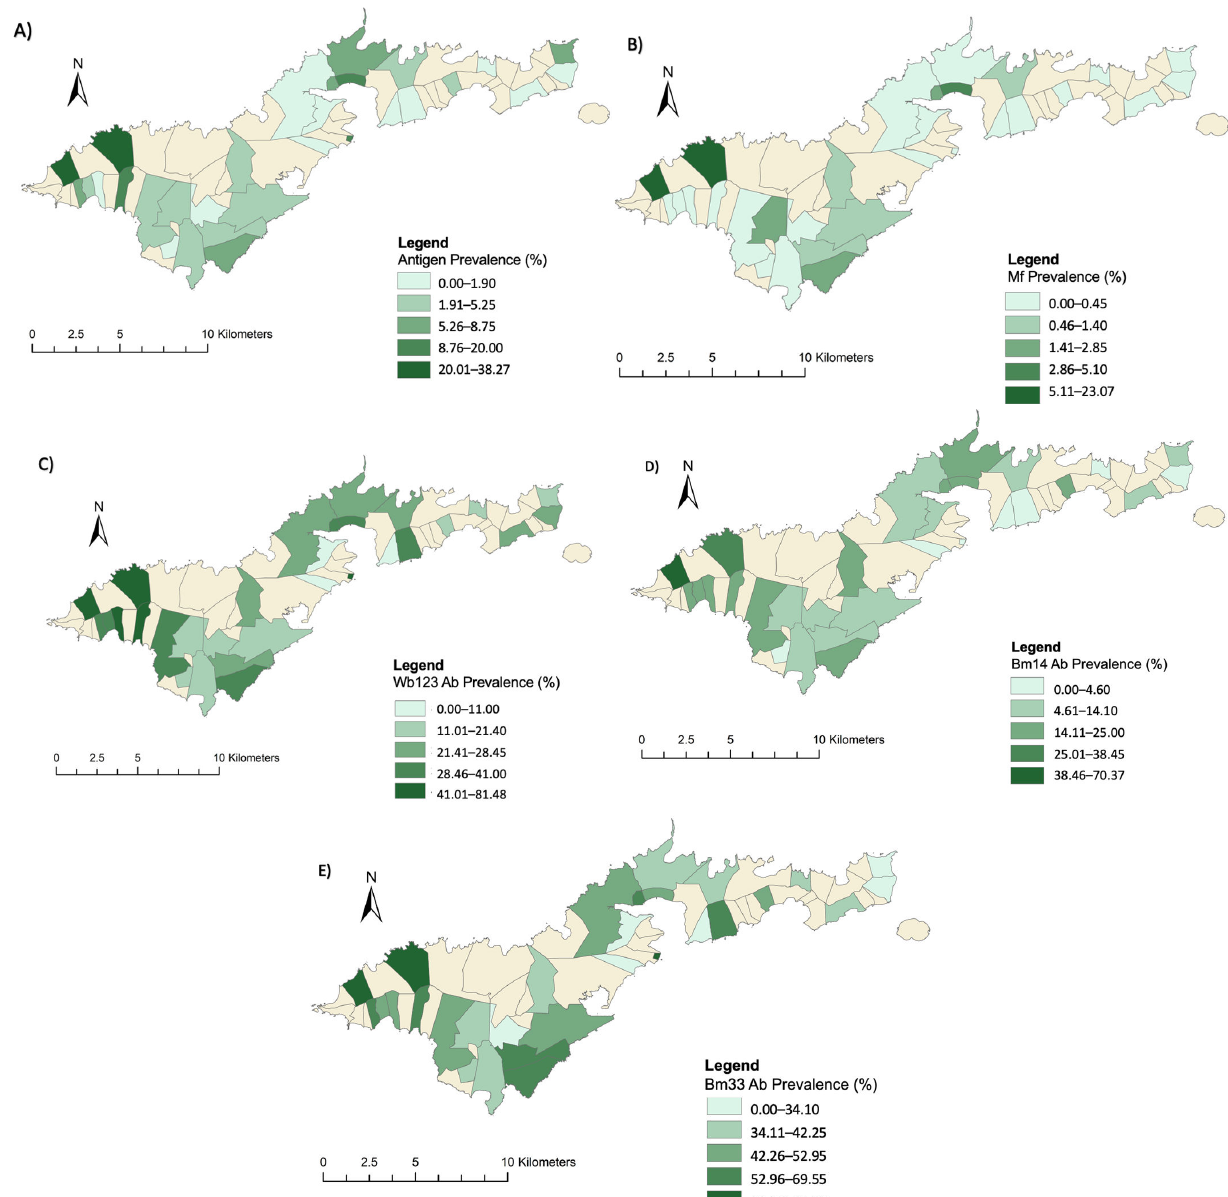
Figure 3. Crude prevalence (%) of each of the five infection markers sampled in the 2016 community survey in American Samoa: ( A ) antigen, ( B ) microfilaria, ( C ) Wb123 Ab, ( D ) Bm14 Ab, ( E ) Bm33 Ab.